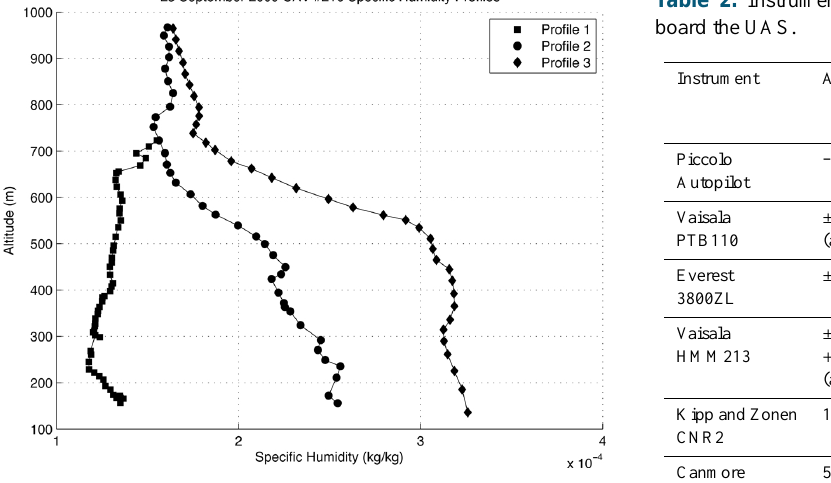
Figure 7. Specific humidity profiles from the 23 September 2009 (UAS #216) flight. Profile 1 was measured at approximately 01:35UTC, Profile 2 was measured at approximately 01:52UTC, and Profile 3 was measured at approximately 02:18UTC on 24 September 2009.